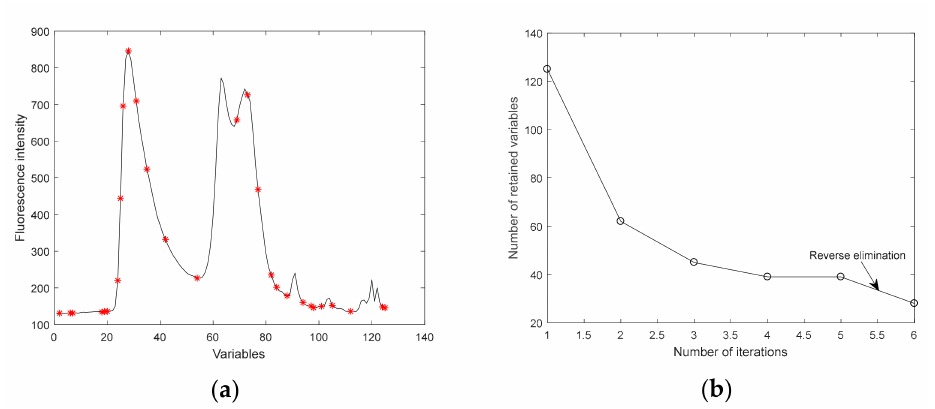
Figure 7. The extracting process of IRIV: ( a ) distribution of effective variables; ( b ) the number of variables in the iterative process of